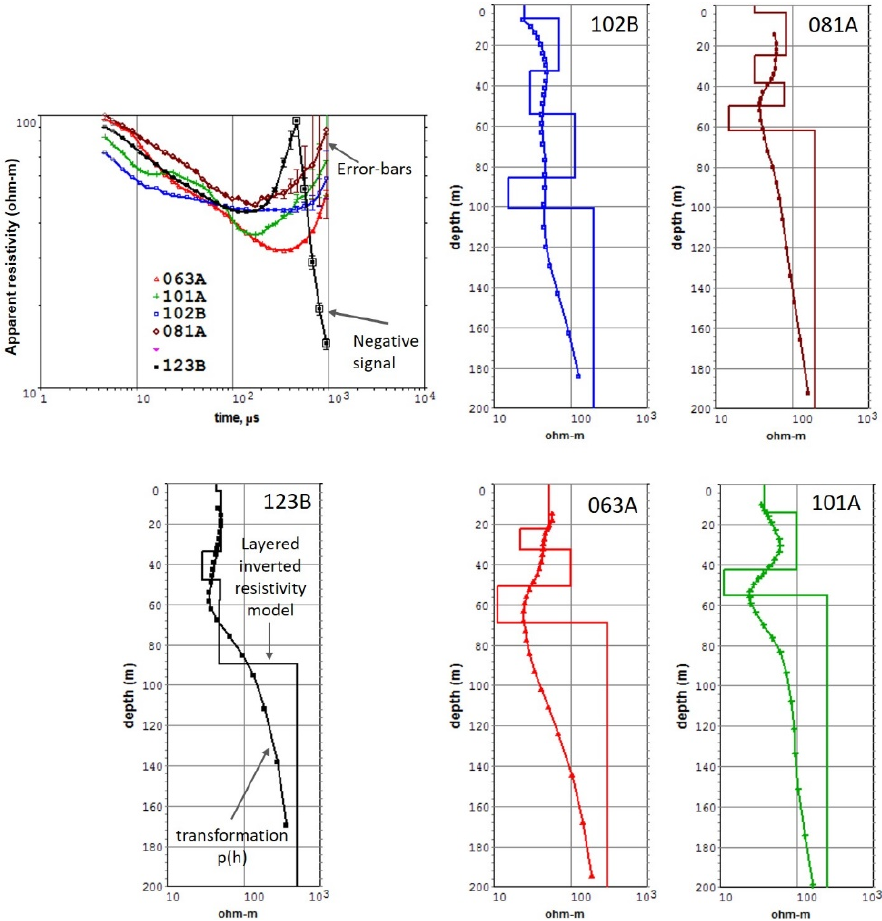
Figure 5. Measured TEM data (apparent resistivity with time) from five different TEM stations (102B, 081A, 123B, 063A, and 101A in the upper-left corner). The error bars in the raw TEM data were used for excluding some noise points from the inversion. Data with negative signal were not considered in the inversion process. The results after transformation (smooth curves with symbols) and Levenberg-Marquardt 1D inversion (piecewise uniform model) are also shown.